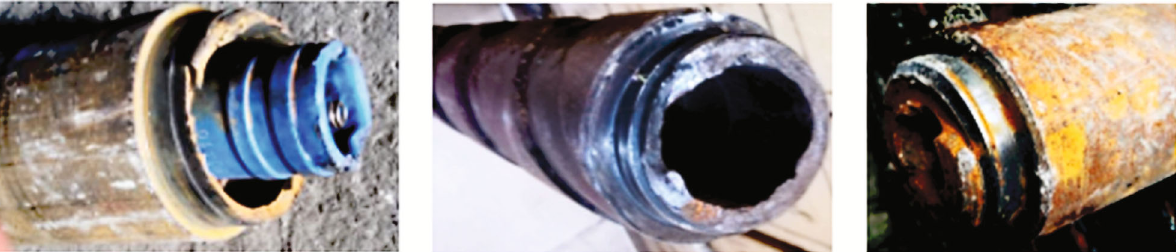
Figure 1: Photos of fracture of the external thread of drill pipe.